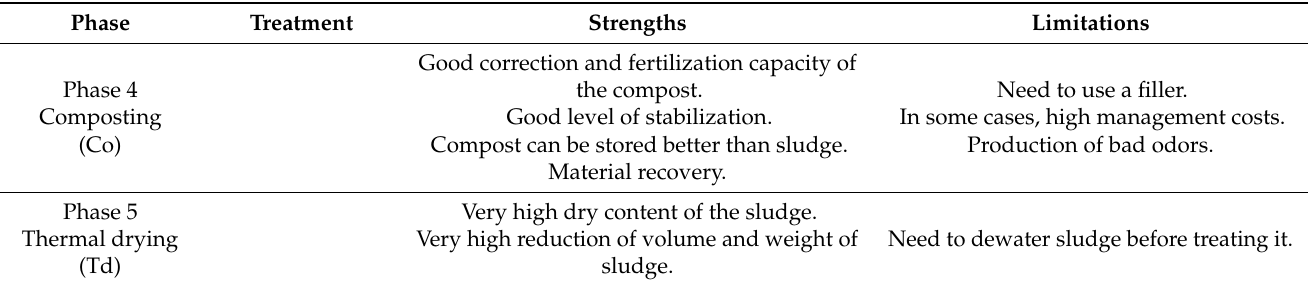
Table 5. Strengths and limitations of all considered alternatives to carry out the composting and thermal drying treatments of the modeled